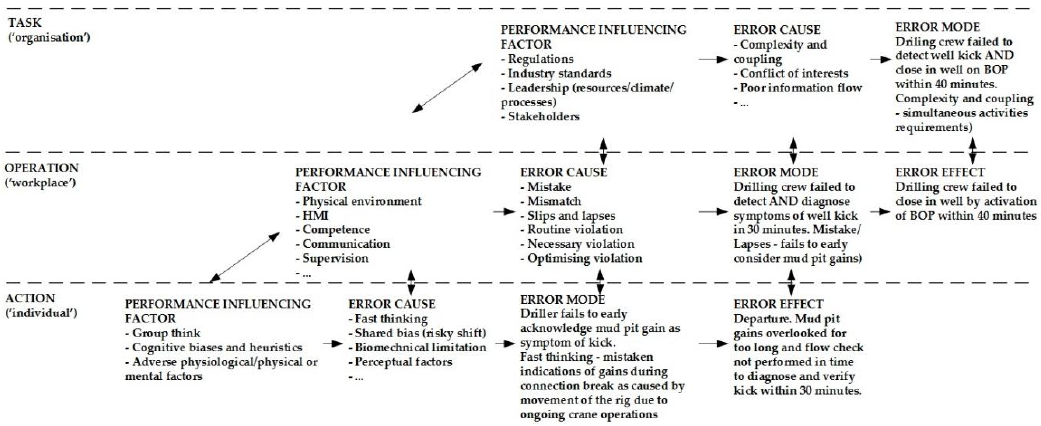
Figure 9. Causal analysis and human failure event (HFE) scenario development in task analysis of offshore drilling activity.